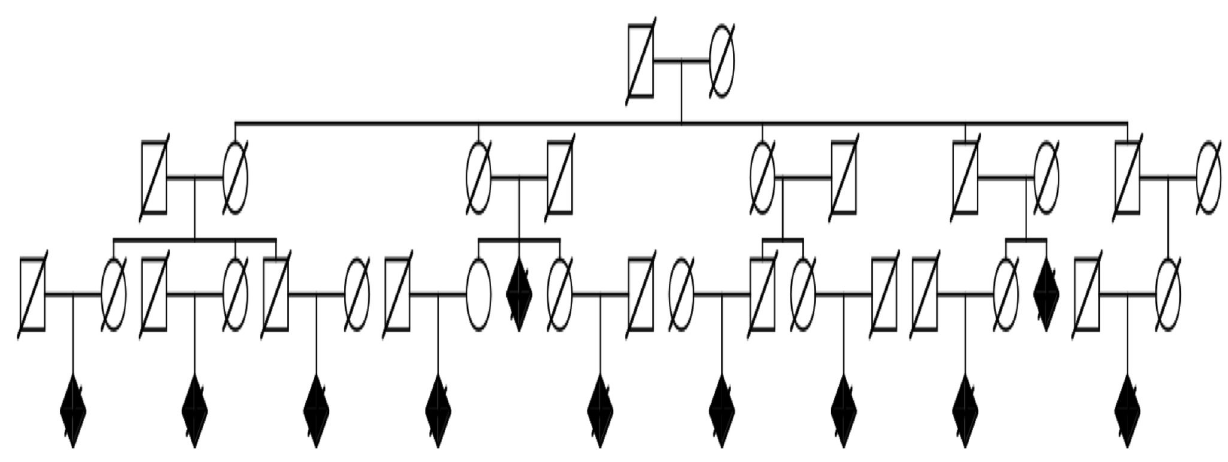
Figure 2. Example of a high-risk Alzheimer’s disease mortality pedigree. Squares are males, circles are females, and diamonds are gender-censored (unspecified gender) individuals. Individuals with a diagonal line are deceased, and shaded shapes are Alzheimer’s disease cases; unaffected siblings are not shown. The founder has more than 4,100 descendants; 11 died from Alzheimer’s disease, only 3.2 Alzheimer’s disease deaths were expected (p= 0.0031). doi: